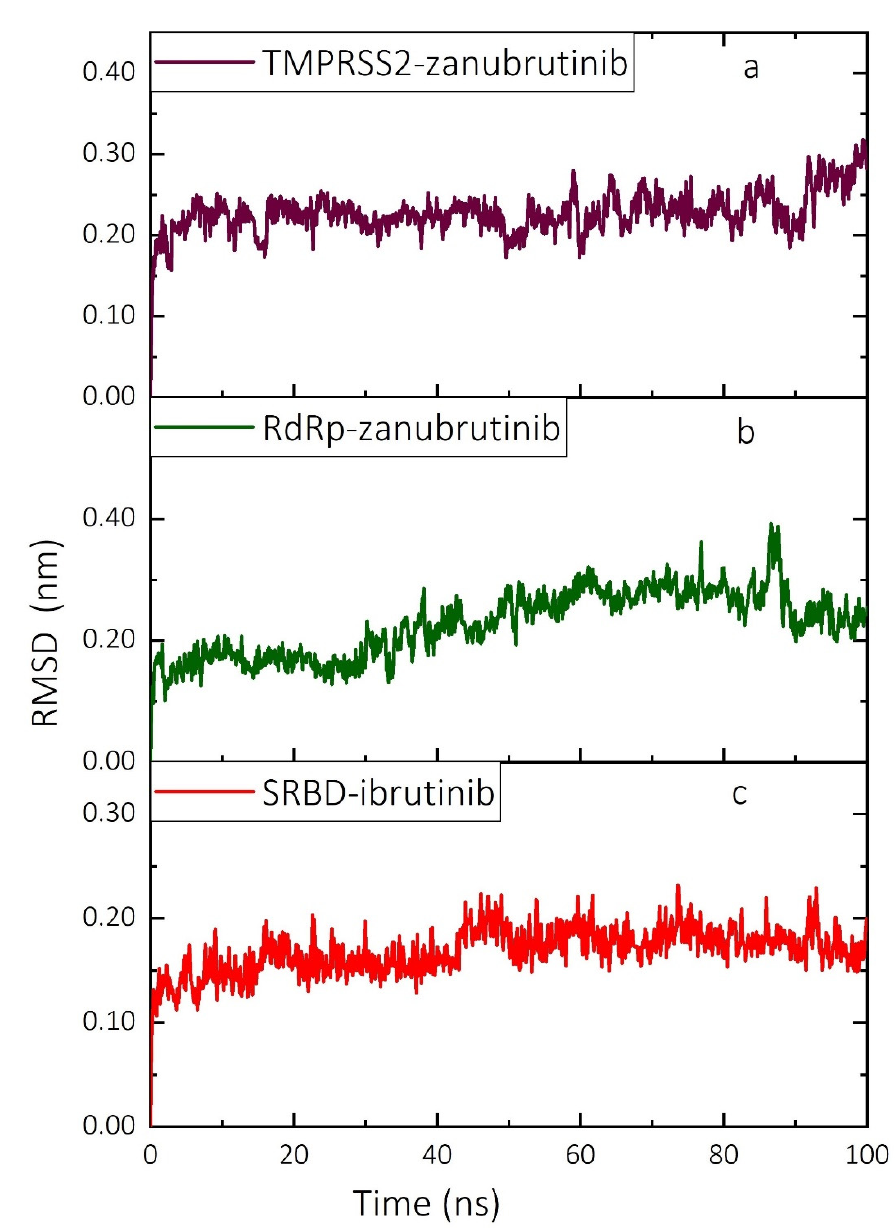
Figure 5. RMSD (nm) of atomic C α positions for the complexes of targets (SRBD, RdRp and TMPRSS2) and ligands (ibrutinib and zanubrutinib) over the 100-ns timescale of MD simulations performed with NAMD. ( a ) TMPRSS2–zanubrutinib complex, ( b ) RdRp–zanubrutinib complex and ( c ) SRBD–ibrutinib complex. SRBD—spike protein receptor-binding domain; RdRp—RNA-dependent RNA polymerase; TMPRSS2—transmembrane serine protease 2; RMSD—root-mean-square deviation.